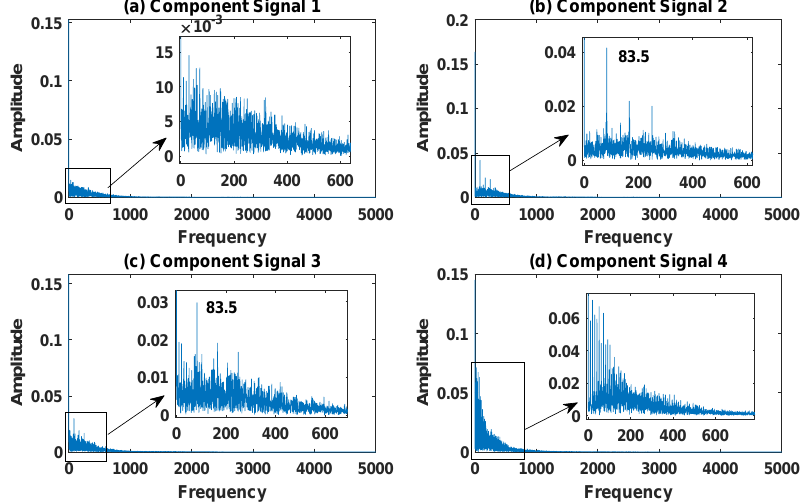
Figure 15. Decomposition results of VMD with m = 16: ( a – d ) envelop of 1st to 4th subcomponents,